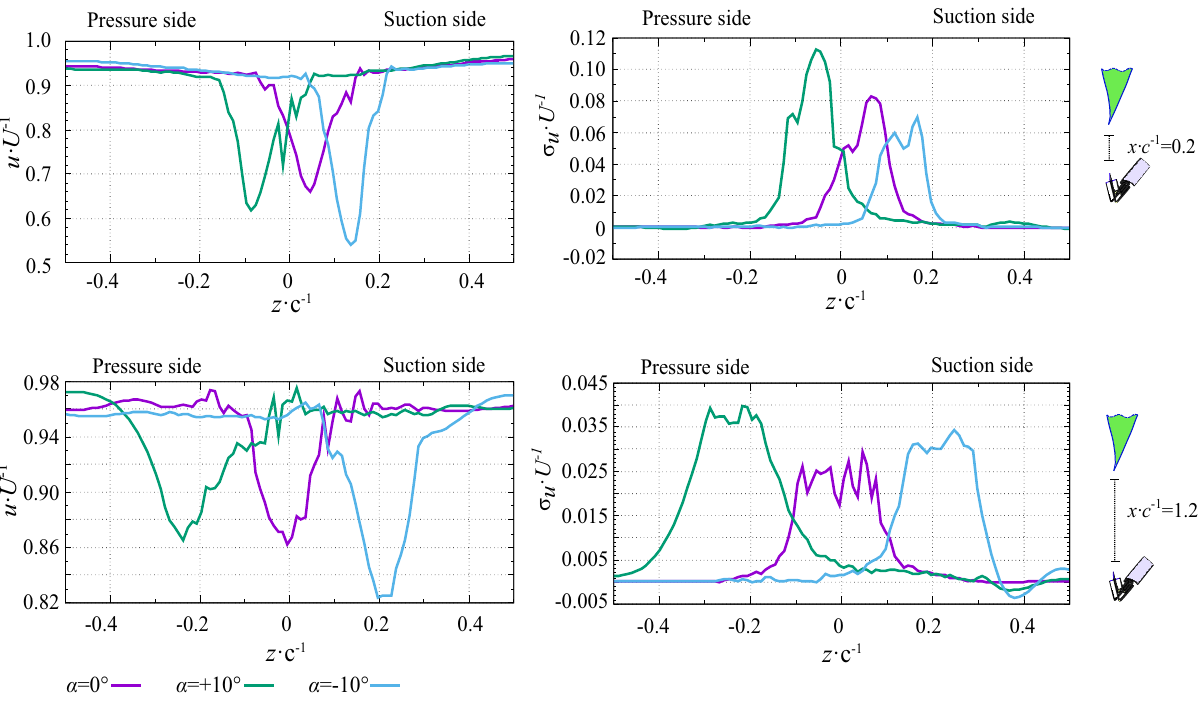
Fig. 3 Normalized cross-sectoral distributions u ⋅ U − 1 and 𝜎 ⋅ U − 1 at Re ≈ 1.7 × 10 5 depending on the distance x ⋅ c − 1 and angle 𝛼 . Green, blue, and light blue indicate the position of the angle of attack + 10 ◦ ,0 ◦ and − 10 ◦ ,